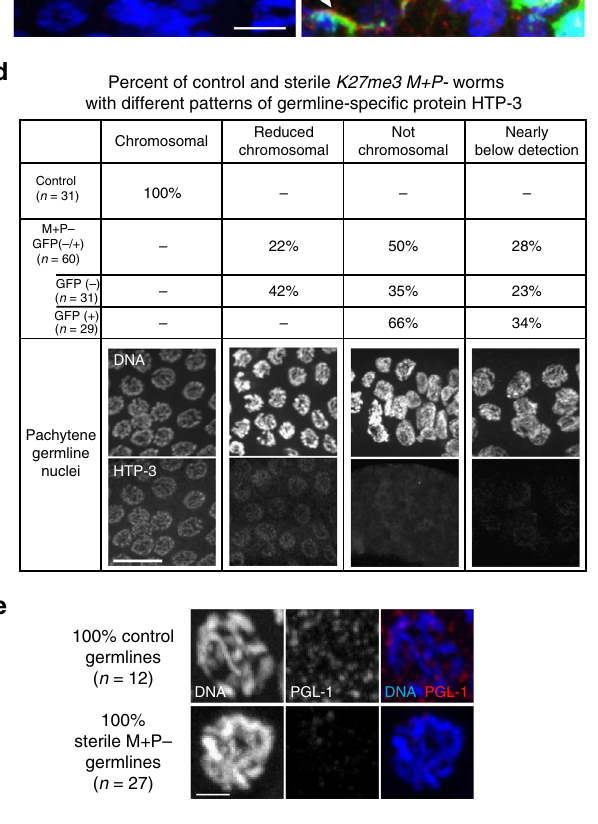
Fig. 3 Inheritance of sperm chromosomes lacking H3K27me3 causes germ cells in offspring to transition toward a neuronal fate. a Immuno fl uorescence images of a sterile germline from a K27me3 M + P − worm in a sensitized genetic background (see text) and carrying an unc-119::gfp neuronal reporter transgene. DNA in blue. GFP in green. Scale bar represents 40 μ m. b Image of GFP in a live K27me3 M + P − worm carrying the unc-119::gfp reporter transgene. Arrowheads point to axo-dendritic processes extending from cells in the gonad with high levels of UNC-119::GFP. GFP in green. Blue is auto fl uorescent gut granules. Scale bar represents 10 μ m. c Immuno fl uorescence images of a control germline and a sterile germline from a K27me3 M + P − worm showing expression of the UNC-119::GFP reporter in green, immunostaining of the neuronally expressed protein UNC- 64 in red, and DNA in blue. Worm schematic indicates the region of germline images. Arrowheads point to axo-dendritic processes co-stained for UNC-119::GFP and UNC-64 in the zoomed-in images. Scale bar in top panel represents 30 μ m. Scale bar in lower panel represents 5 μ